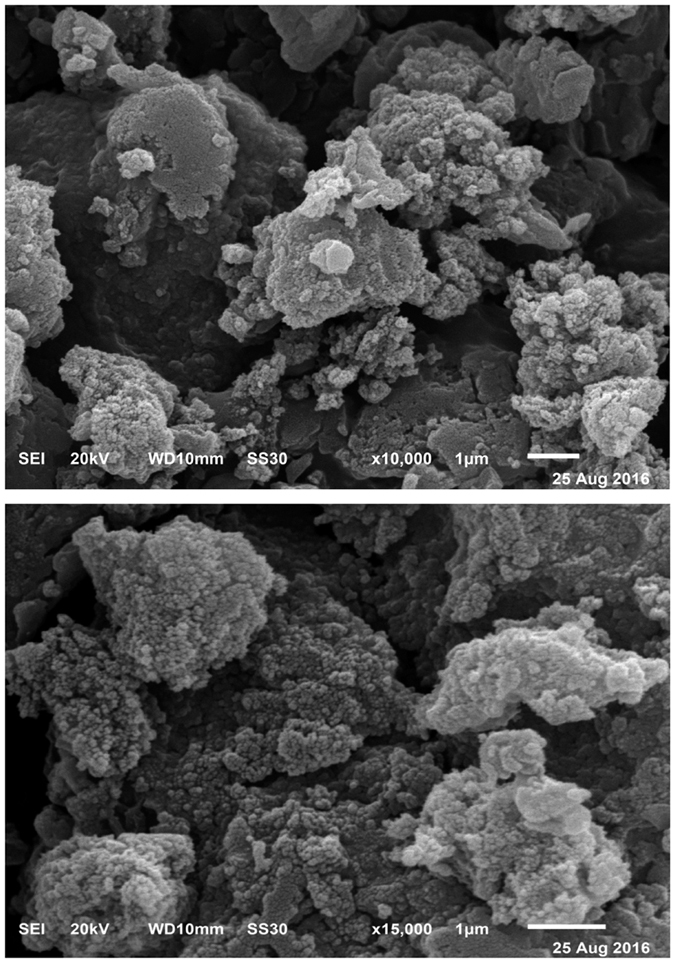
Scanning electron microscope micrographs of the extracted melanin pigment granules at different magnifications showing small spheres.